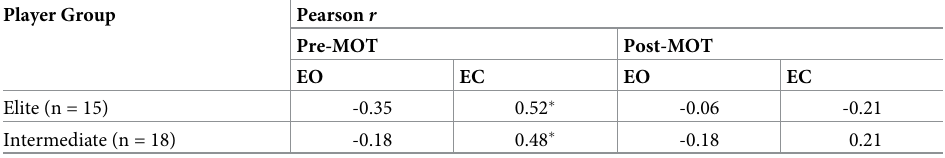
Table 1. Correlations between IAPFs and tracking accuracy in the MOT task, stratified by eyes open (EO) or closed (EC) and by player group.